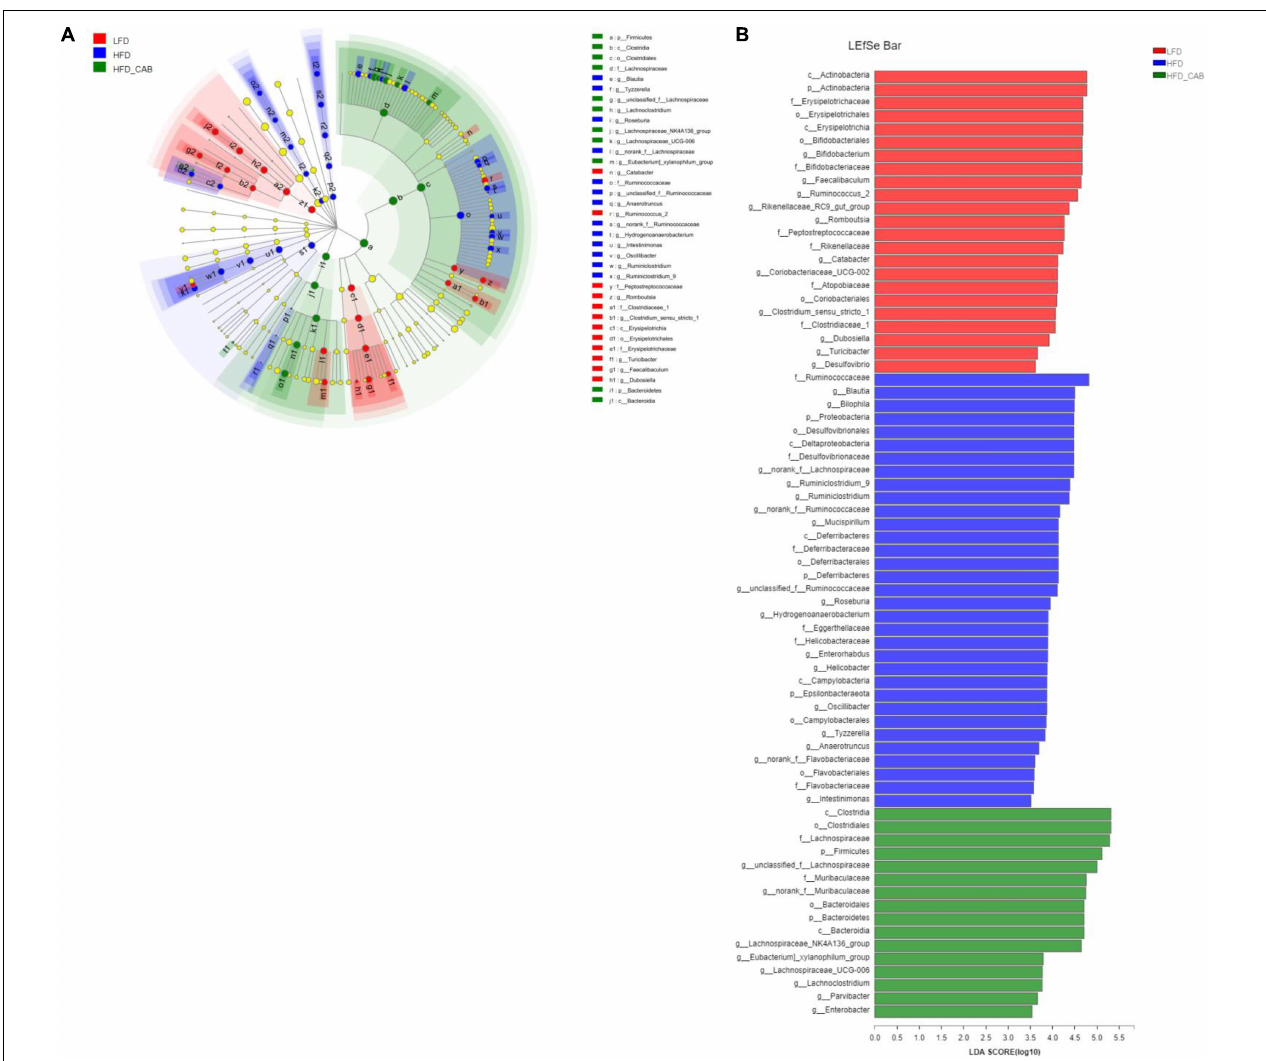
FIGURE 7 | Effect of cooked adzuki bean supplementation on key phylotypes. (A) Cladogram generated from LEfSe analysis showing the relationship between taxon (the levels represent, from the inner to outer rings, phylum, class, order, family, and genus), and (B) linear discriminant analysis (LDA) scores derived from LEfSe analysis (the length of the bar represents the LDA